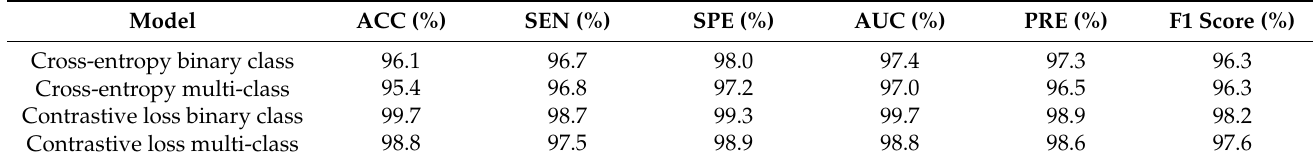
Table 3. Performance evaluation metrics for the proposed model.